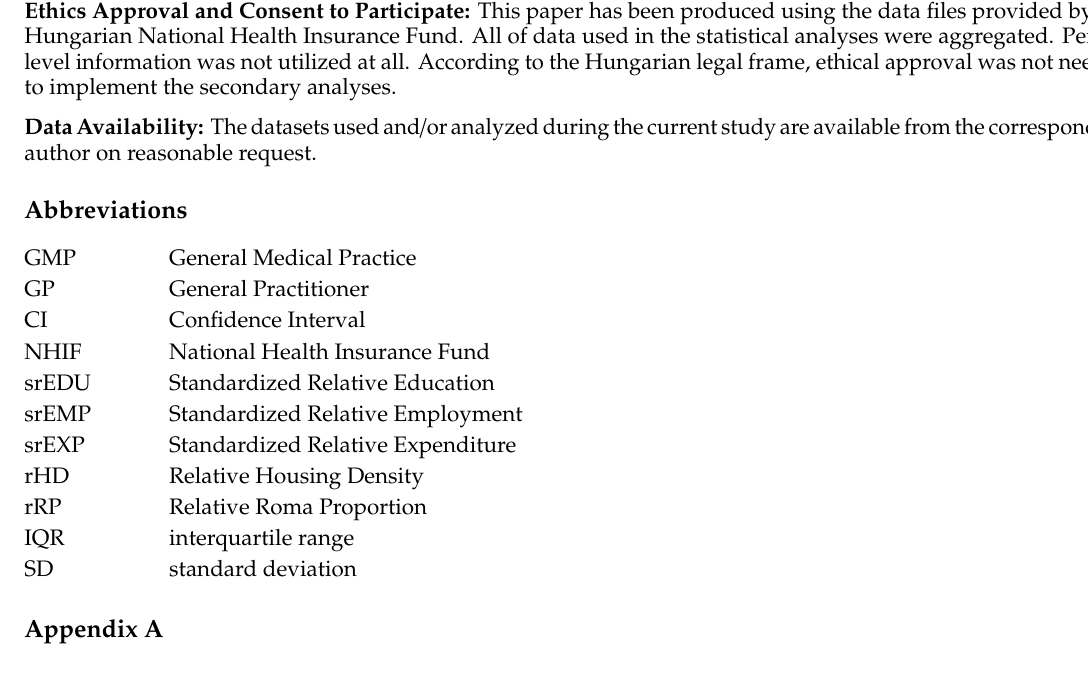
Table A1. Average number of years of school attendance by demographic strata in Hungary according to the Census